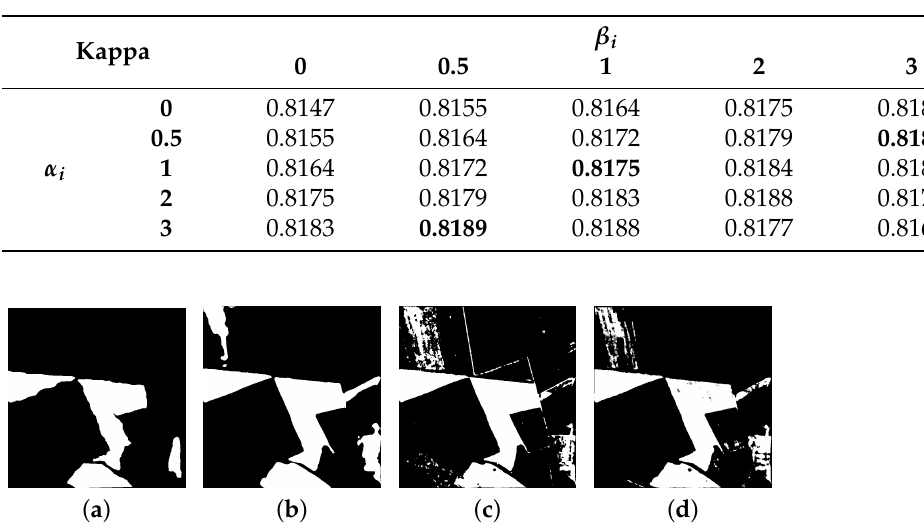
Table 4. Ablation study of α i and β i on Tiszadob of OSCD datasets.